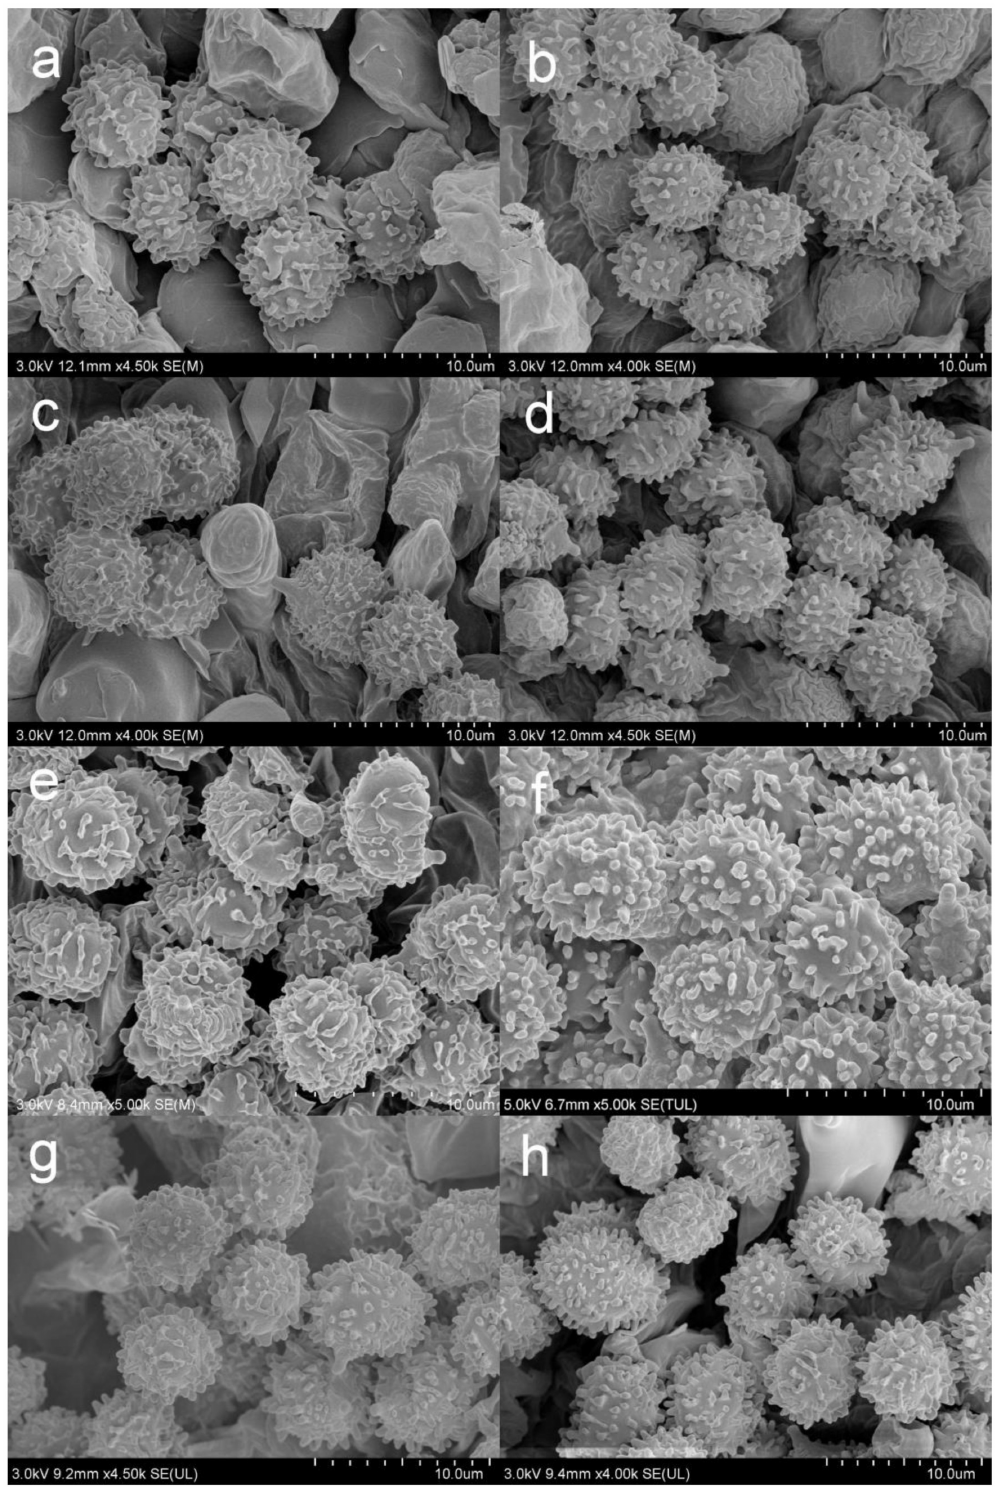
Figure 4. SEM photos of basidiospores. ( a ) Russula begonia . ( b ) R. gracillima . ( c ) R. roseola . ( d , e ) R. pho- tinia . ( f ) R. leucomarginata . ( g ) R. rhodochroa . ( h ) R. rufa